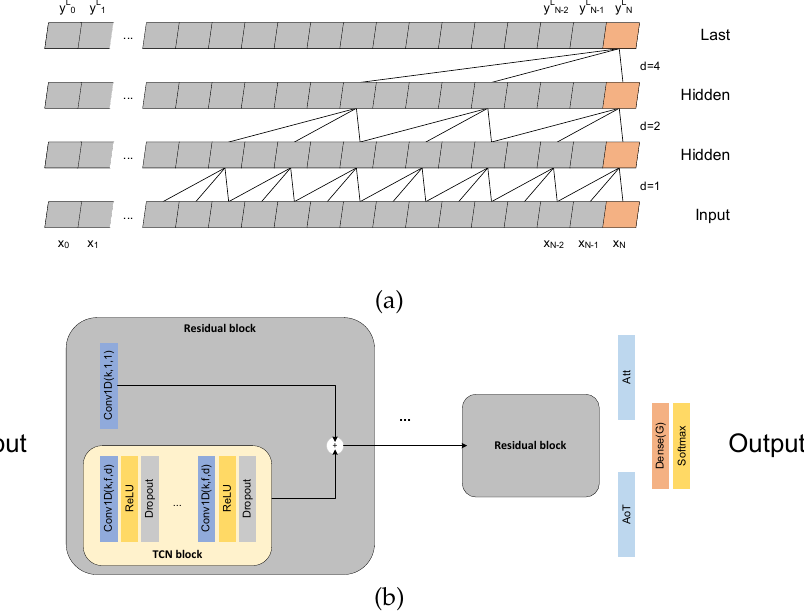
Figure 1. The TCN architecture. ( a ) Graphical representation of temporal causal convolutions with exponential dilation factor d . ( b ) Each residual block performs a summation of a causal convolution and the output of the TCN block that consists of a succession of causal convolutions, ReLU, and Dropout layers. The Conv1D layer hyperparameters are k number of filters, f filter size, and d dilation